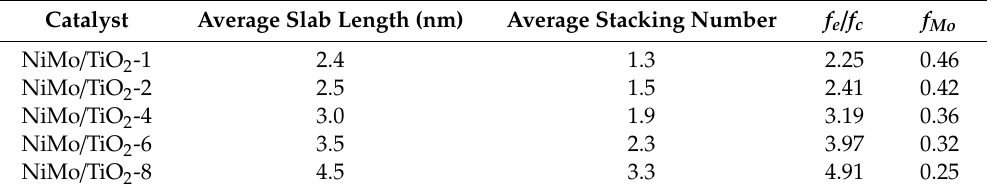
Table 2. Statistical HRTEM results of various